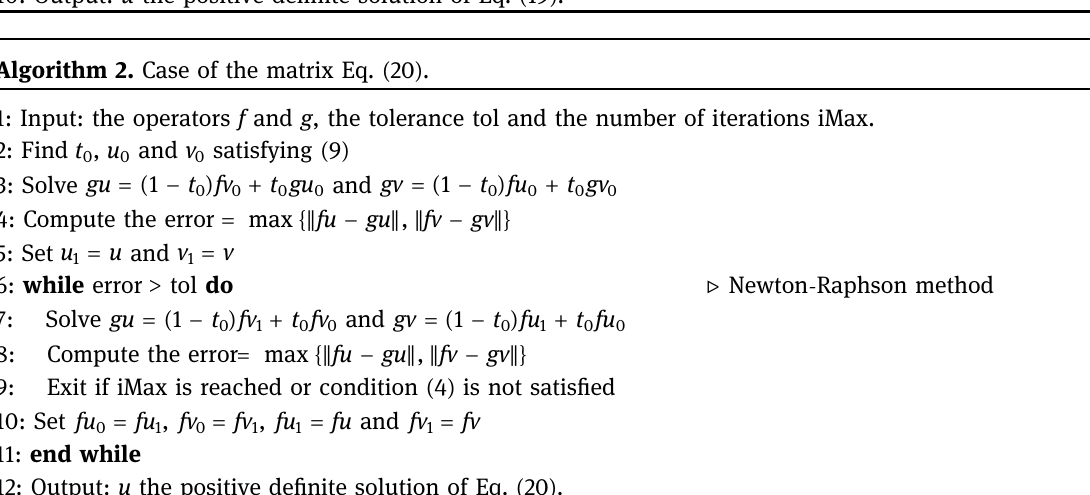
Algorithm 2. Case of the matrix Eq. ( 20 )